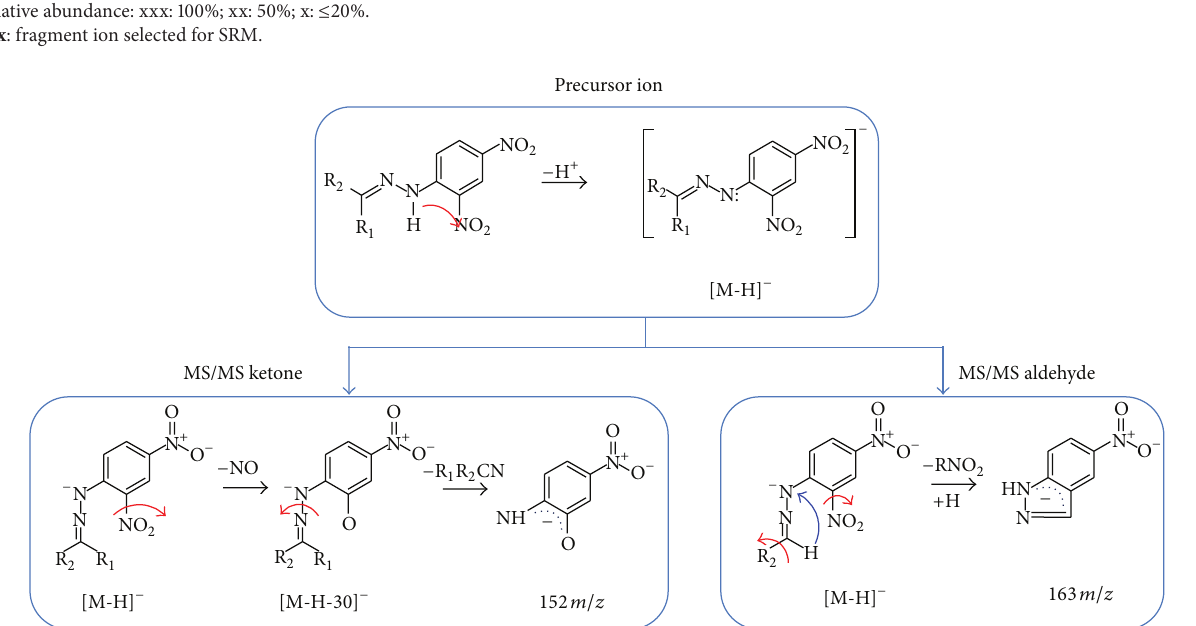
Figure 2: Schematic representation of the precursor deprotonated molecule ([M-H] − ) and main fragments formations for aldehydes and ketones